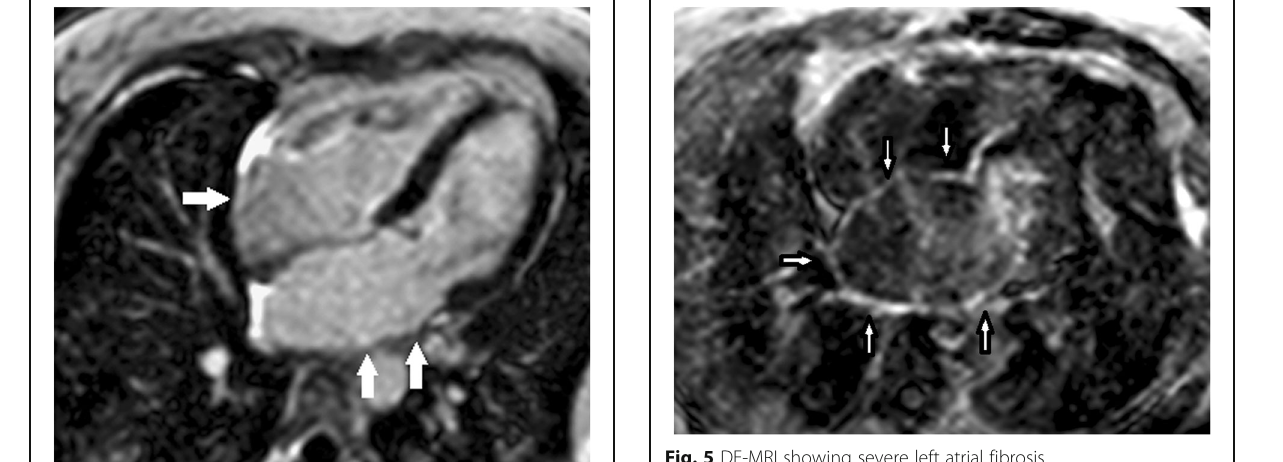
Fig. 5 DE-MRI showing severe left atrial fibrosis (circumferential,